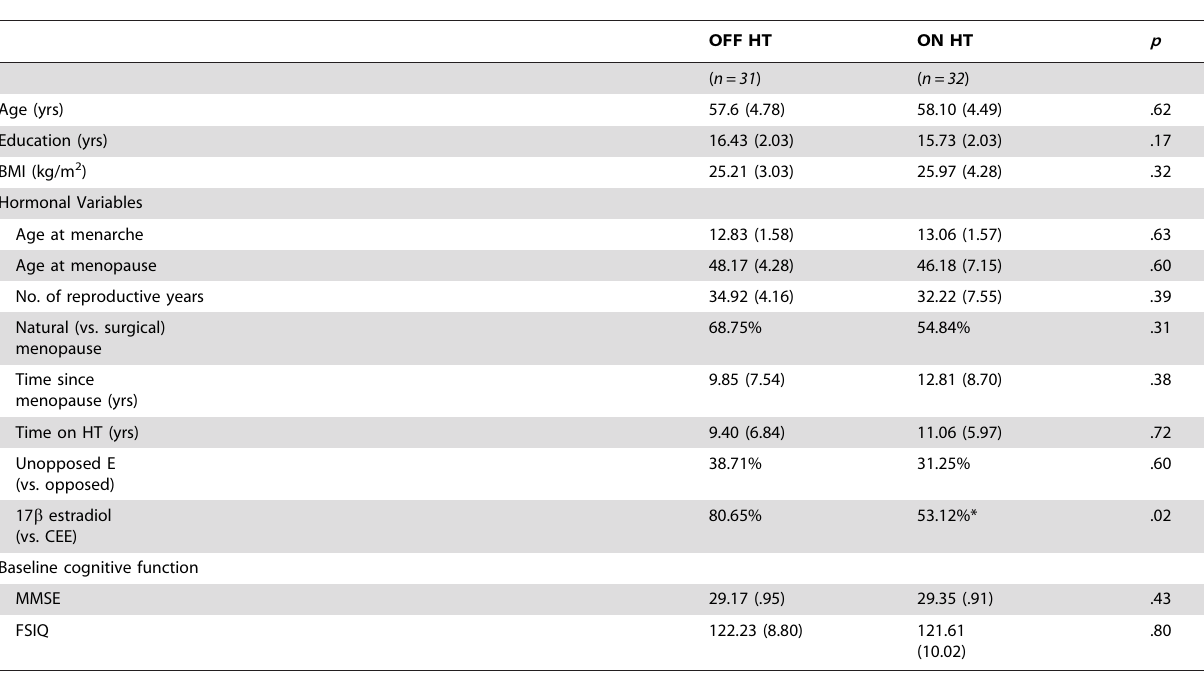
Table 1. Characteristics of the study sample by HT